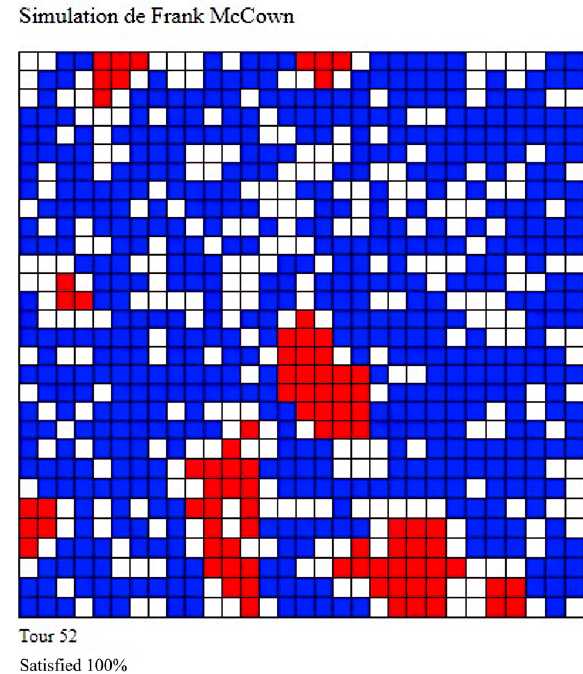
Fig. 11. Spatial and phenomenal segregation in Blida’s Liberty Square.